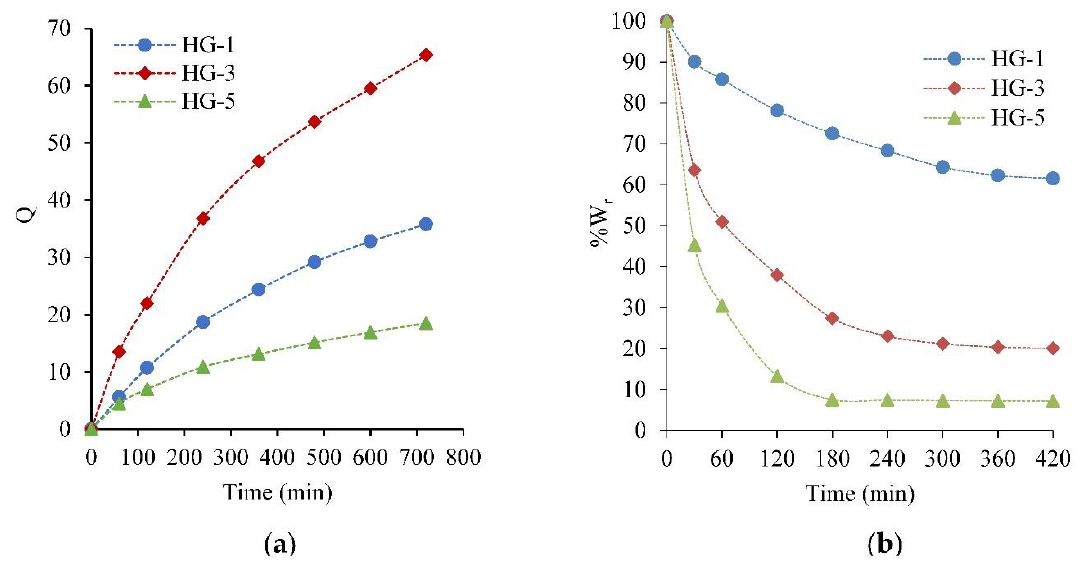
Figure 3. ( a ) Water absorption kinetics (expressed as water absorption degree) at 25 °C, ( b )